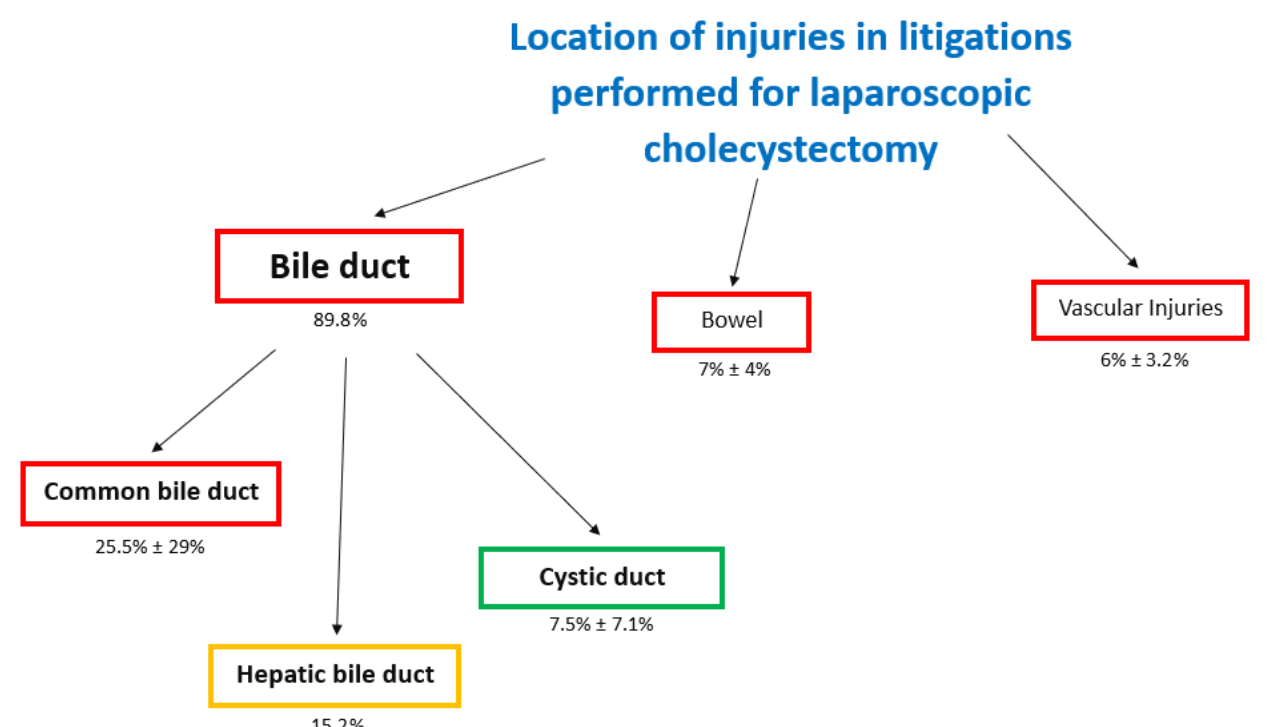
Figure 11. Flowchart of causes of location of injuries in litigations performed for laparoscopic cholecystectomy.